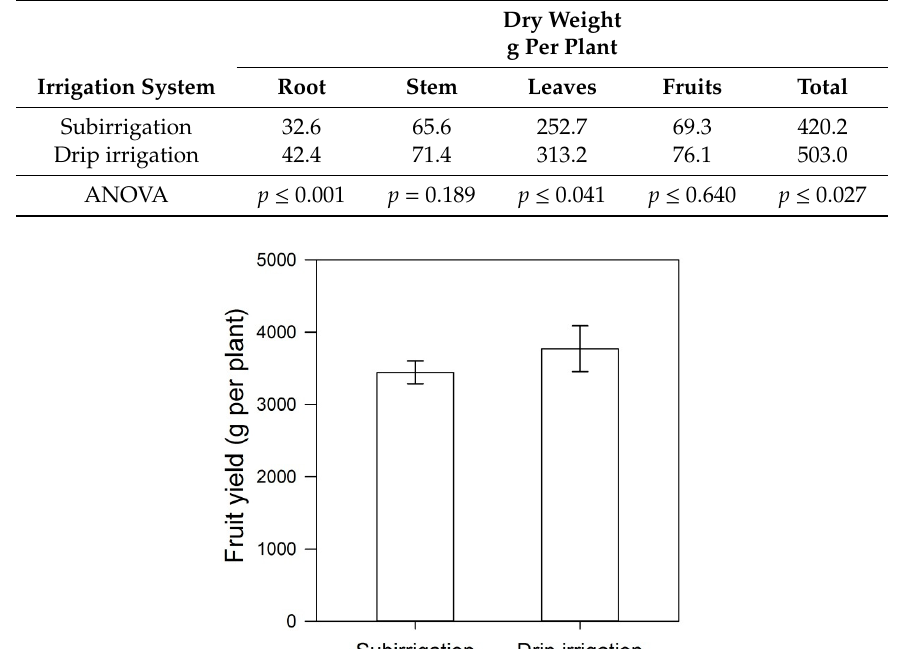
Table 1. Dry weight of plant parts of tomato ( Solanum lycopersicum L.) grown in two irrigation systems.